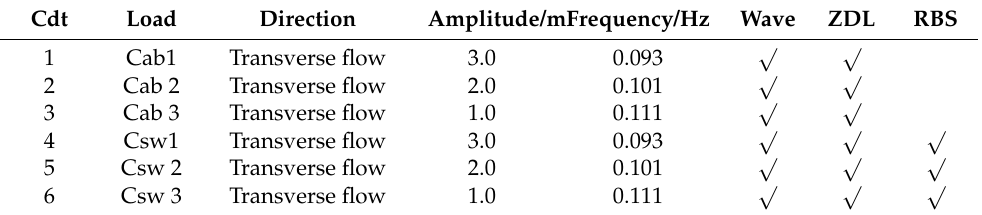
Table 3. Parameters of the load of the suspension point in the z direction